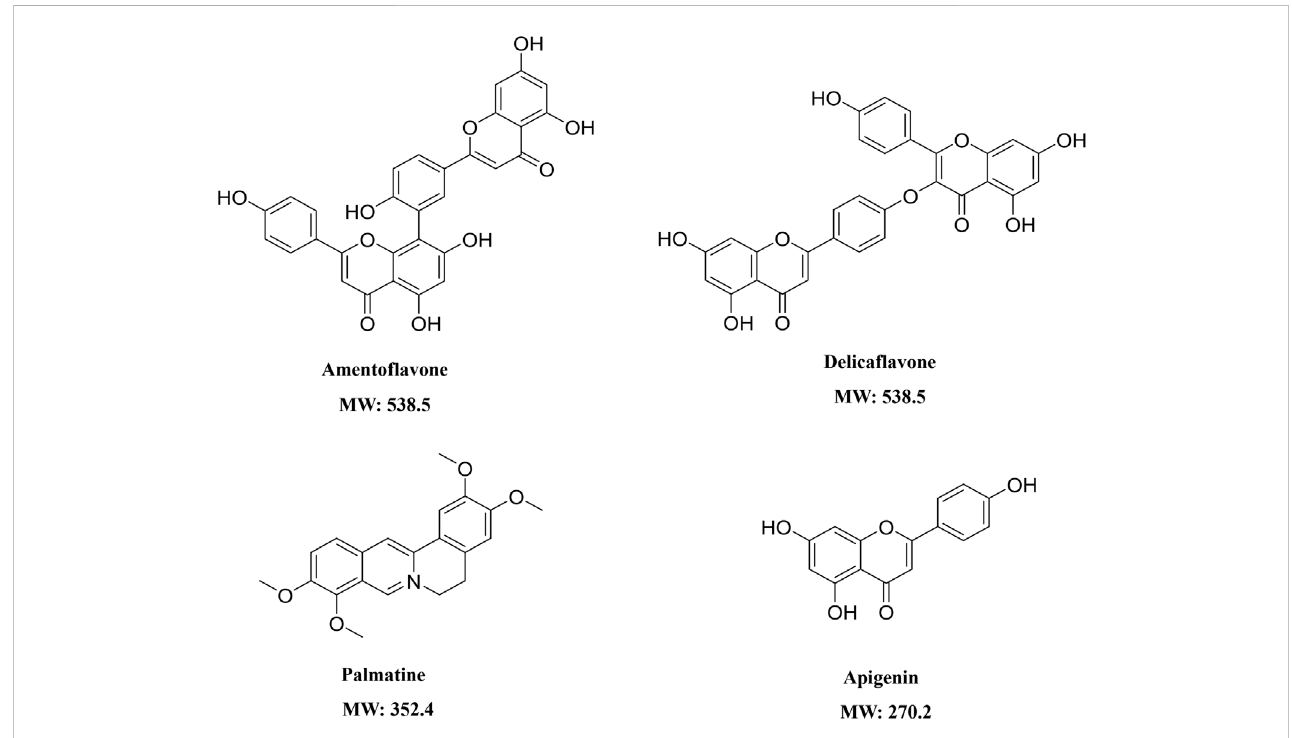
FIGURE 1 Structural formula and molecular weight of the components in SDEA.